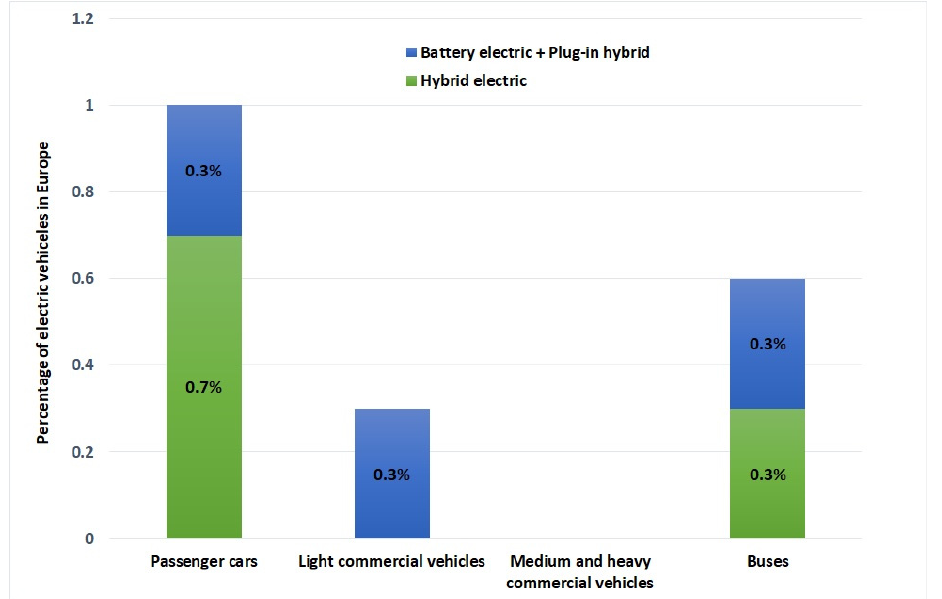
Figure 2. EU-wide market share of electric cars, by purpose and type of power supply in 2018 [22]. Energies 2020 , 13 , x FOR PEER REVIEW